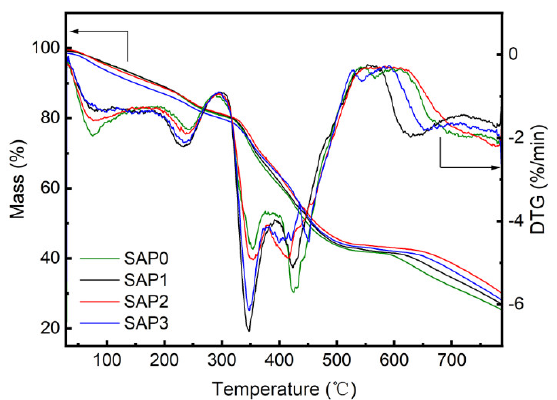
Figure 4. Thermogravimetric analysis curves of SAP0, SAP1, SAP2, and SAP3. Mass losses of the three modified SAPs were slower than that of SAP0, as shown in Figure 4. The temperature for the mass retention rate to be reduced by 50% was 448, 455, 468 and 459 ◦ C for SAP0, SAP1, SAP2 and SAP3, respectively. At 784 ◦ C, the mass retention rates of SAP0, SAP1, SAP2, and SAP3 were 25.5%, 27.0%, 30.8%, and 28.0%,